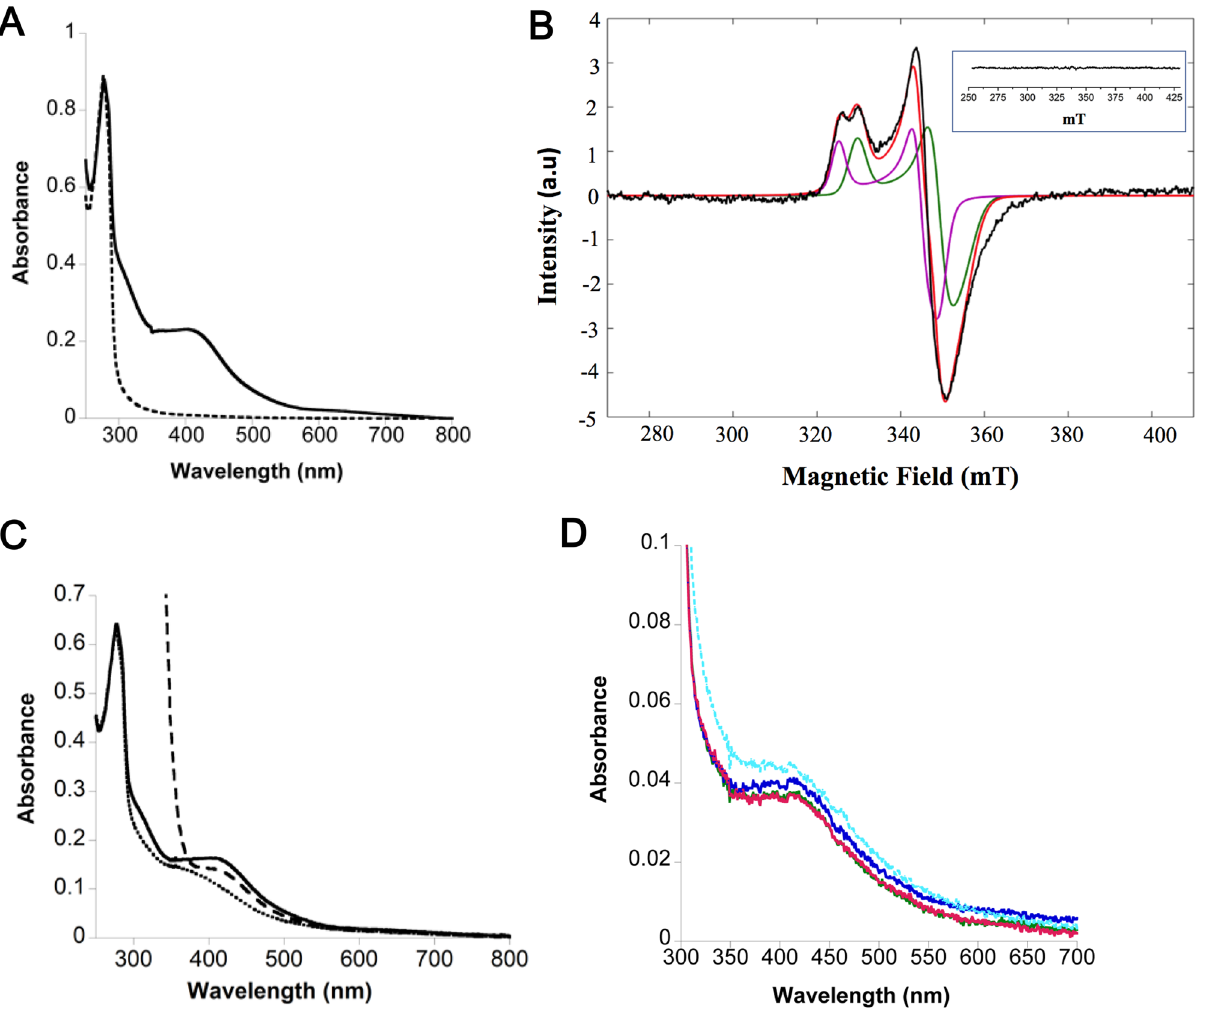
Figure 2. Spectroscopic characterization of MmNcsA. ( A ) UV–visible spectra of apo-MmNcsA (dashed line) and holo-MmNcsA (full line). The spectra were recorded with 40 µM protein in 25 mM HEPES pH 7.5, 200 mM NaCl. ( B ) X-band EPR spectrum of reduced holo-MmNcsA at 20 K. The buffer signal was removed from the experimental spectrum before simulation. Two clusters were simulated separately. For cluster 1 (magenta line), the 3 distinct principal values of the g-tensor are g x = 1.890, g y = 1.918, gz = 2.033 and the Gaussian distribution deviations σ(g x ) = 0.03, σ (g y ) = 0.001, σ (g z ) = 0.002; for cluster 2 (green line), g x = 1.919 g y = 1.944, g z = 2.061 and σ(g x ) = 0.01, σ (g y ) = 0,001 and σ (g z ) = 0.001. The experimental (black line) and simulated spectra (magenta and green lines for the two cluster species with red line for their sum) are superimposed. Inset: EPR spectrum of holo-MmNcsA before reduction . ( C ) UV–visible spectra of holo-MmNcsA (19 µM), before (full line) and after reduction with a 25-fold excess of dithionite (dashed line) or NaBH 4 (dotted line). ( D ) UV–visible absorption spectrum of holo-NcsA before and after reaction showing that the absorption band at 400 nm characteristic of the [4Fe-4S] cluster is not modified during the assay: 5 µM holo-NcsA just after adding 5 µM tRNA Lys UUU , 500 µM ATP, 250 µM Na 2 S and 2.5 mM MgCl 2 (blue) and after 30 min incubation at 37 °C (cyan). A control sample containing the same reactants except Na 2 S was monitored at the beginning of the reaction (green) and after 30 min incubation